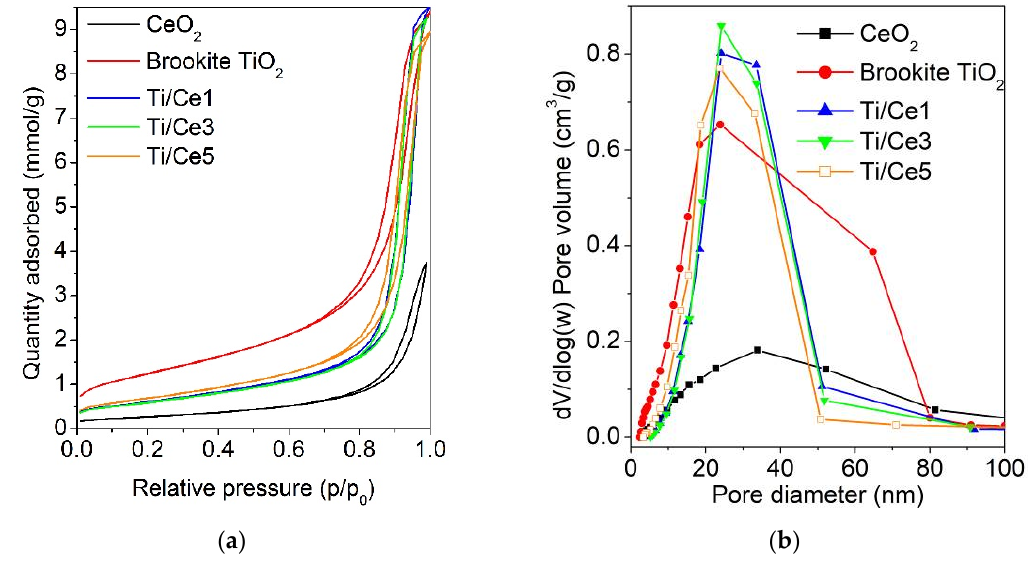
Figure 3. ( a ) Nitrogen physisorption curves and ( b ) the Barrett, Joyner and Halenda (BJH) curves of the analyzed samples.